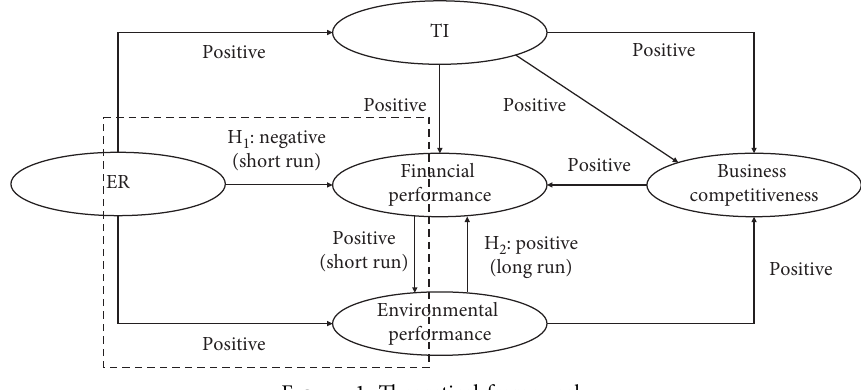
Figure 1: Theoretical